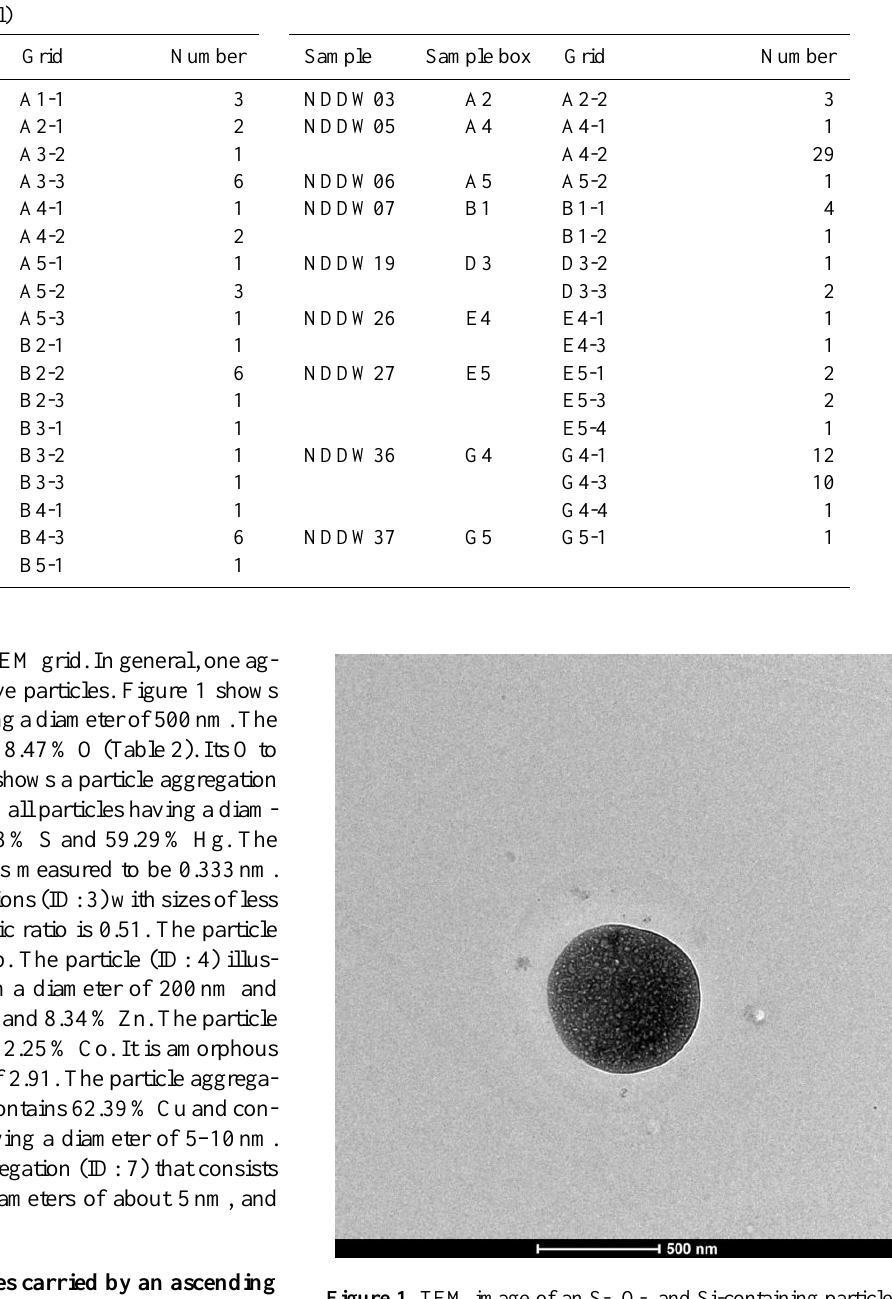
Table 1. Number of sulfur-containing particles or particle aggregations number from the Dongshengmiao deposit on 100µm × 100µm TEM grids. Sulfur-containing particles or particle aggregations carried by ascending gas flow above the soil (that had flown through the soil)